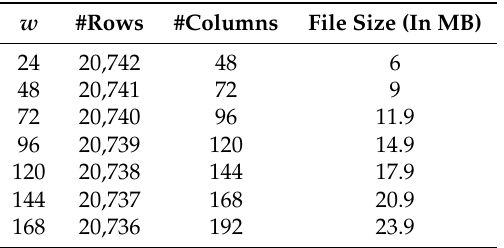
Table 1. Dataset information depending on the value of w